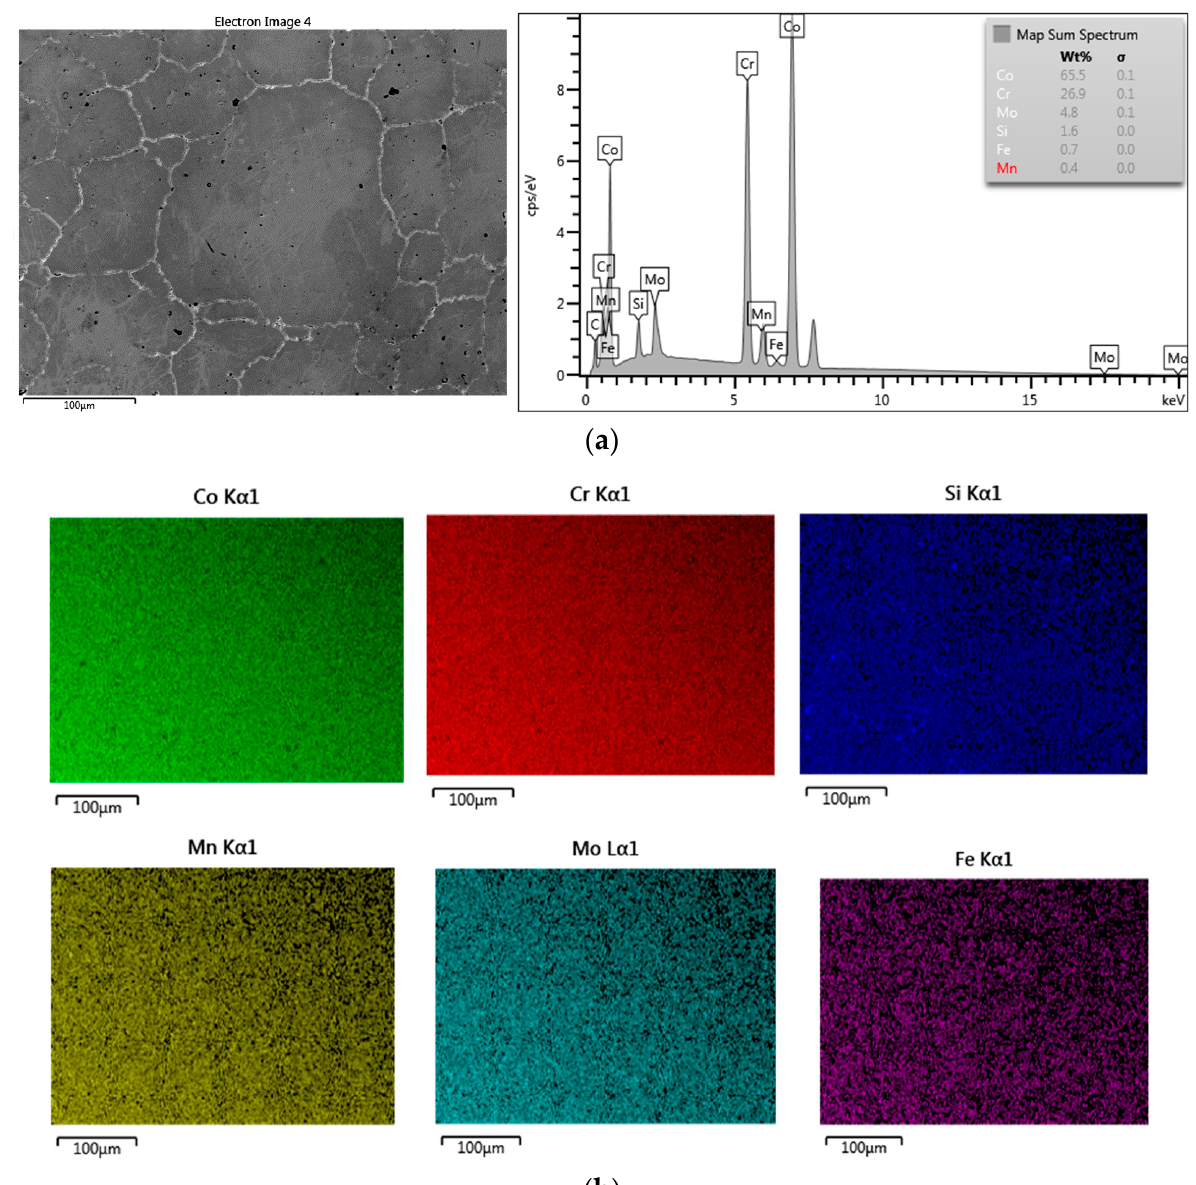
Figure 1. SEM–EDS results for SM-Control: ( a ) SEM-SE micrograph showing morphology with averaging EDS results from the area presented; ( b ) the surface distribution of Co, Cr, Si, Mn, Mo, Fe.